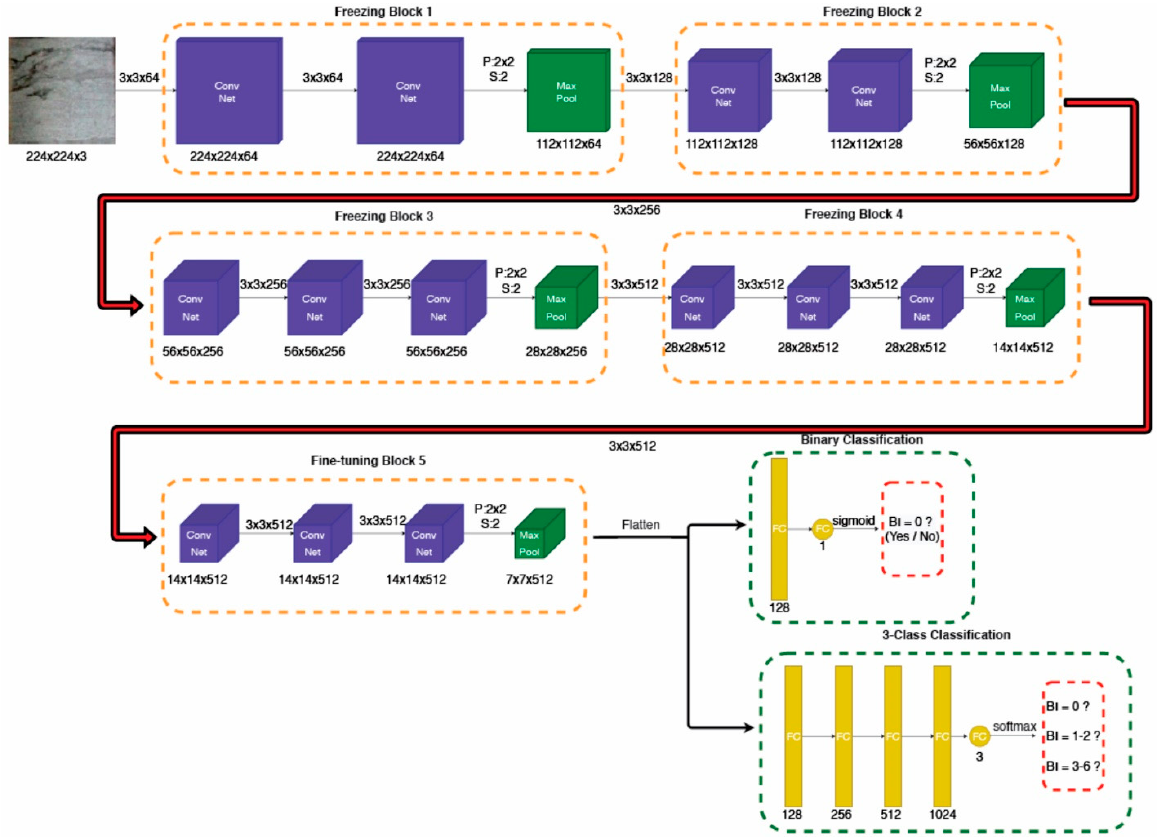
Figure 2. A convolutional neural network architecture based on VGG-16 with fully connected layers at the end. The architecture describes the routines for both binary and multi-class classifications. The input is a three-channel (red, green, blue) image. The binary classification problem outputs whether the input image is bioturbated or not. The multi-class classification problem outputs the class of the given image in terms of its bioturbation index.